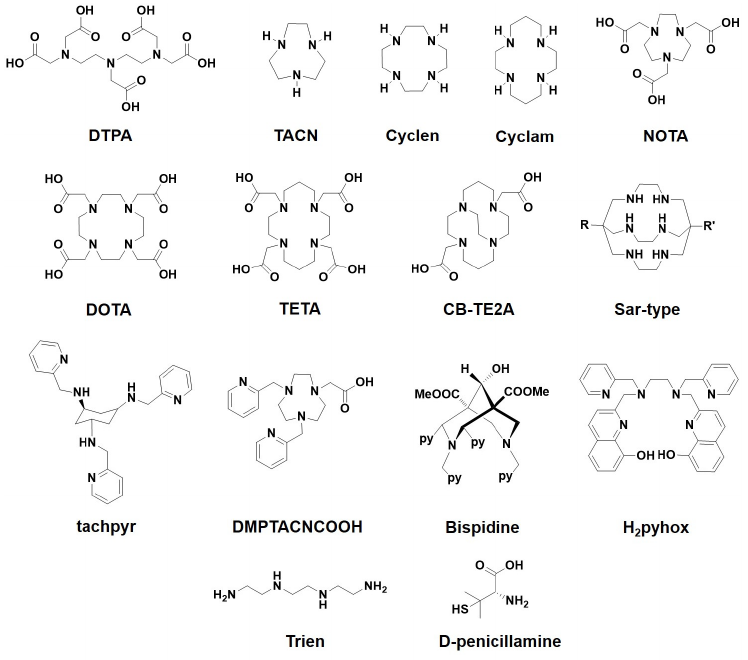
Figure 4. Selected copper (II)